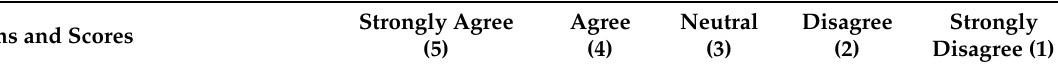
Table 2. Post-cavity-preparation questionnaire. We asked students to rate their agreement with the following